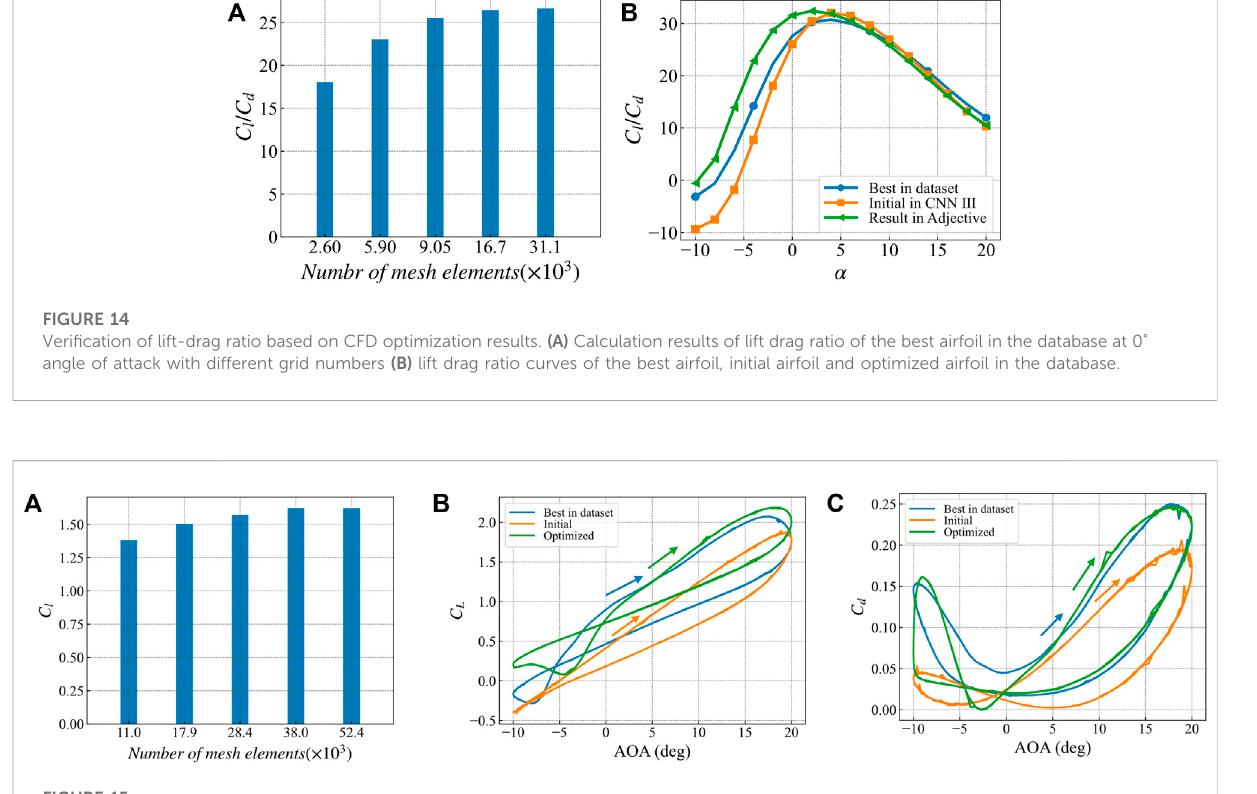
FIGURE 15 Stall characteristics of optimization results. (A) Calculation results of lift drag ratio of different grid numbers for the best airfoil in the database at 10 ° angle of attack (B) change curve of lift coef fi cient of the best airfoil, initial airfoil and optimized airfoil in the database with angle of attack